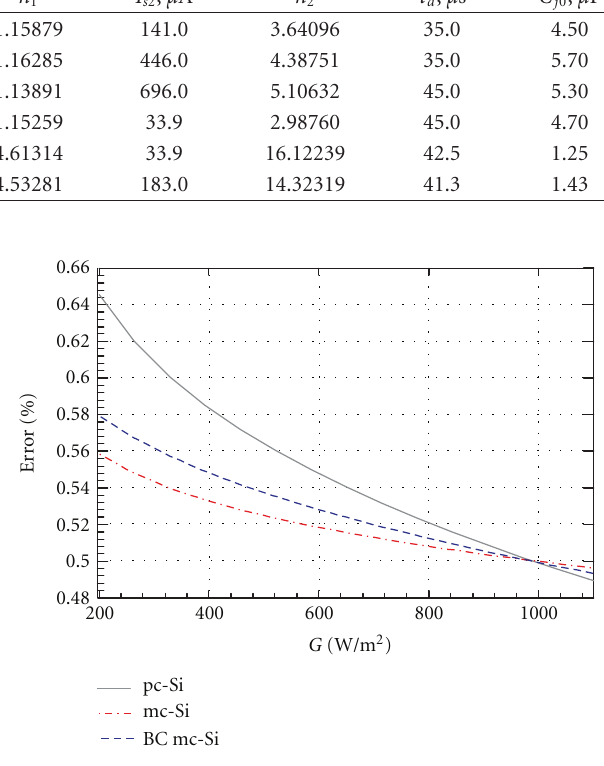
ff ect of irradiance variation on transient